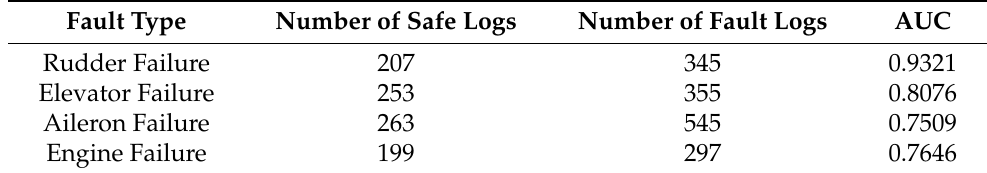
Table 4. Fault detection results on the flight with recovery measures. Our approach accomplished significant performances in detecting failures on the rudder and elevator, but required further improvements in identifying failures on the aileron and the